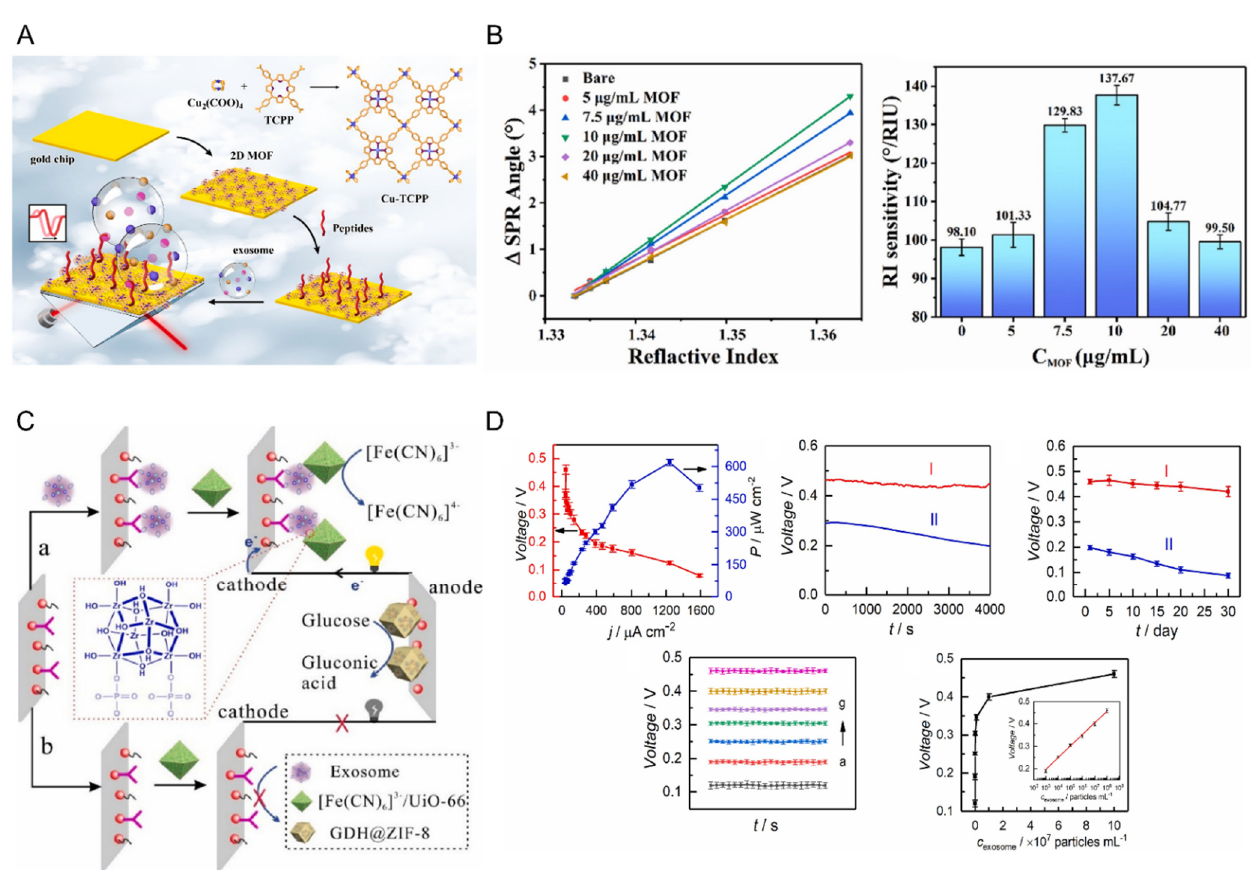
Figure 5. ( A ) Schematic diagram of Cu-based MOF-based SPR sensor, ( B ) SPR performance improvement according to MOF application, ( C ) Zr-based MOF-based self-powered sensor configuration, and ( D ) exosome detection performance of the proposed sensor evaluation. This was reproduced with permission from [38,51], published by Elsevier, 2022 and 2021, respectively.